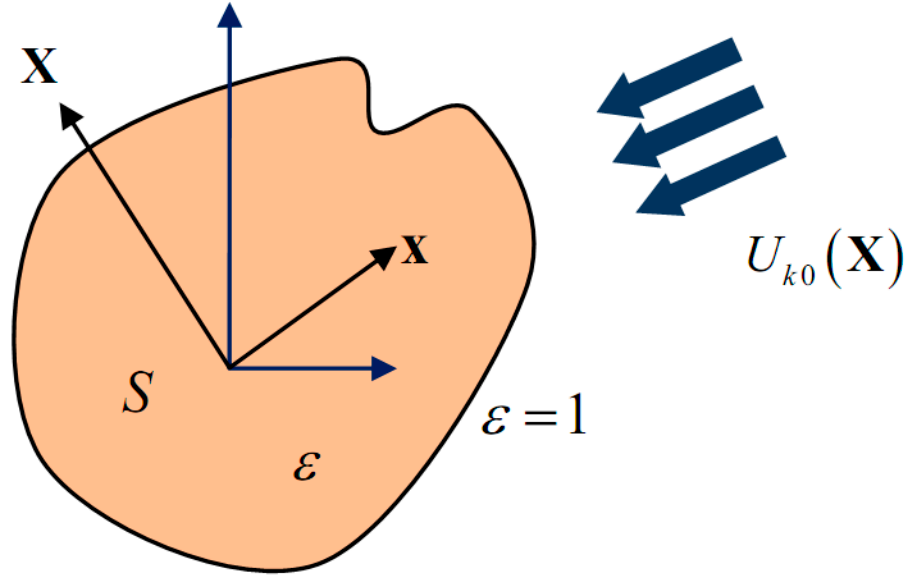
Figure 1. Configuration of the problem: two-dimensional dielectric cylinder with arbitrary cross section S is excited by the quantum light with spectral density U k 0 ( X ) ; x ∈ S , X / ∈ S . If the inside field is known, the outside field may be found via the integration over the body volume